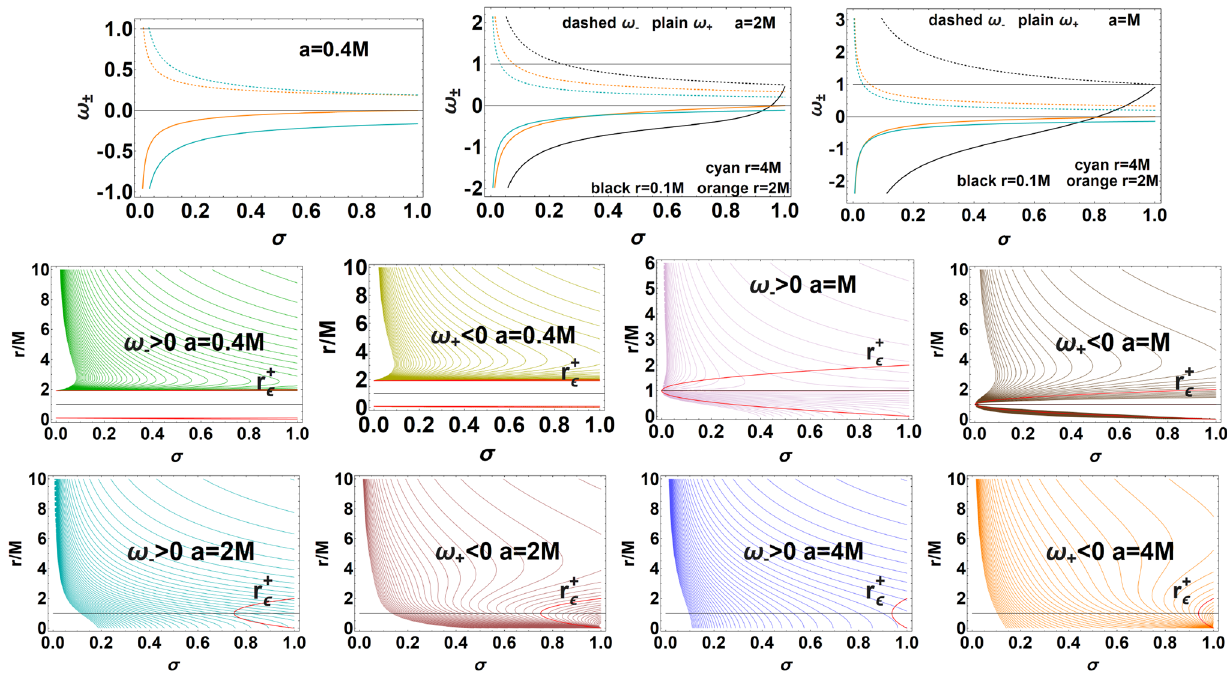
Fig. 12 Upper lines: bundle frequencies ω ± as functions of the plane σ ∈ [ 0 , 1 ] for fixed spin a / M and radius r / M of the extended plane. Note the frequencies signs (negative for retrograde photon motion)) and the decreasing magnitude with the plane σ at fixed r . The limiting roles of the horizons and ergosurfaces can also be noted. Below lines: